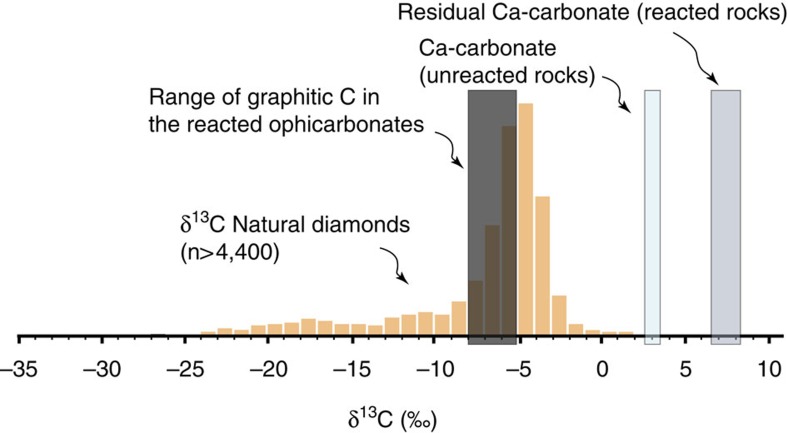
δ13C composition of graphite and carbonate in the studied rocks.The δ13C composition of natural diamonds31 is also reported for reference.